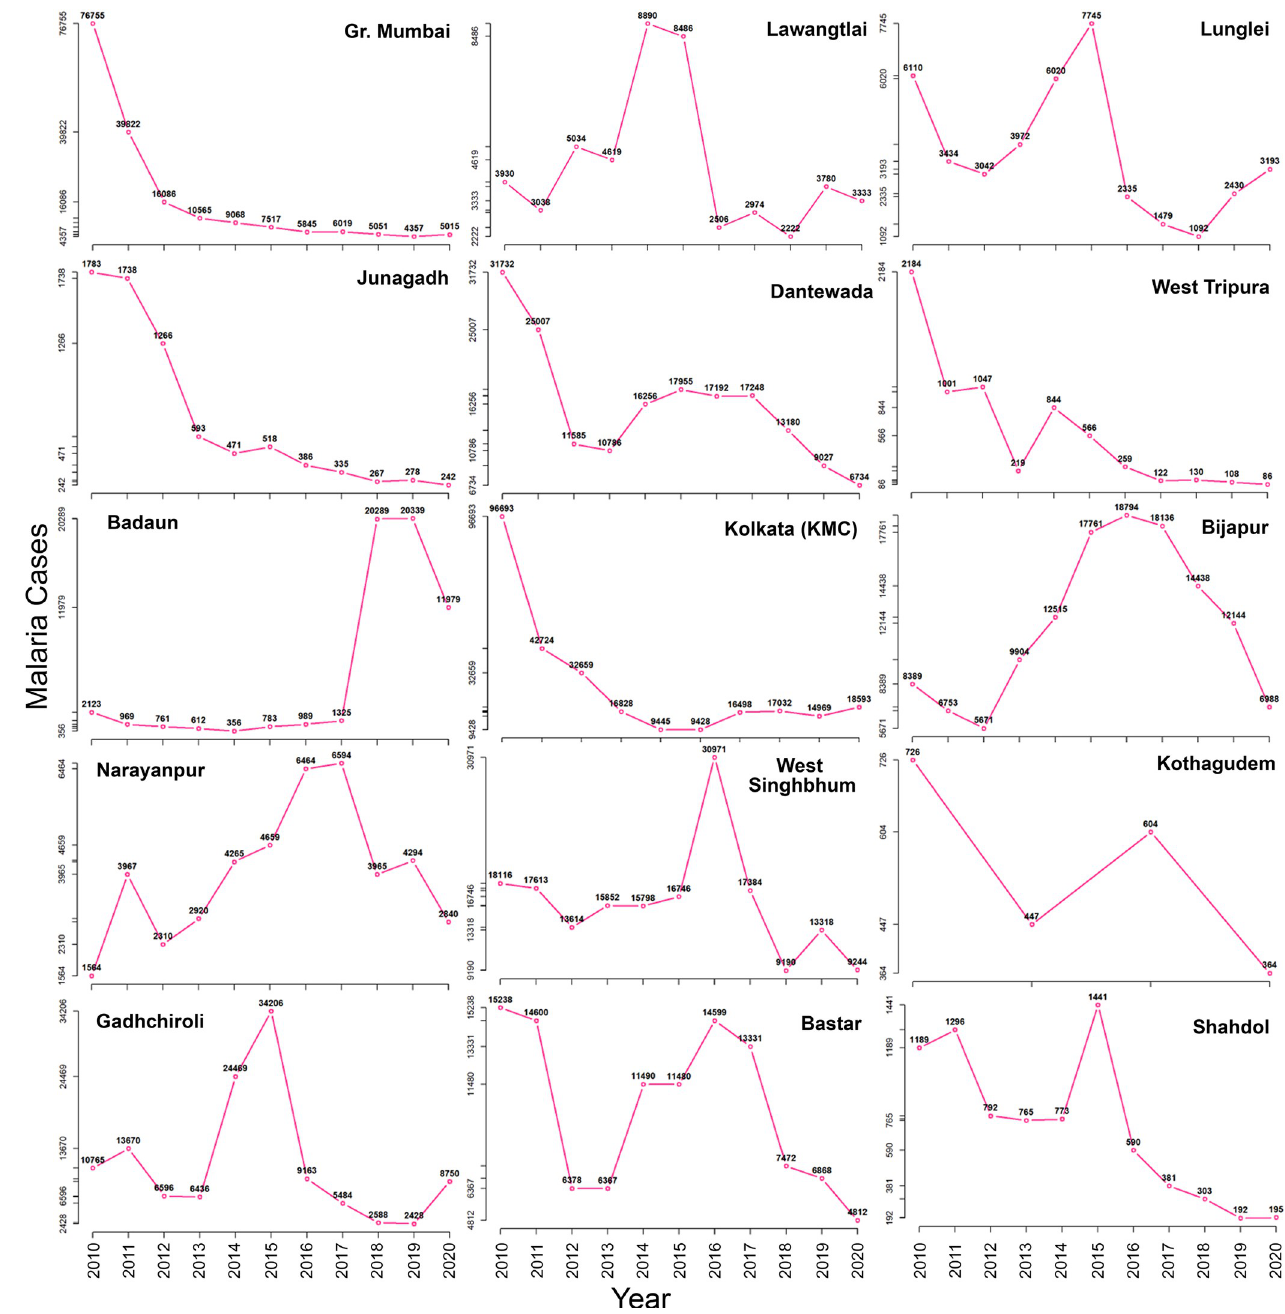
Fig 5. Longitudinal distribution of malaria cases in the last ten years in the cohort of fifteen most vulnerable districts of India that would reach zero case status after 2030 if necessary interventions are not deployed in time. District (State): Greater. Mumbai (MH), Lawangtlai (MZ), Lunglei (MZ), Junagadh (GJ), Dantewada (CT), West Tripura (TR), Badaun (UP), Kolkata (WB), Bijapur (CT), Narayanpur (CT), West Singhbhum (CT), Kathagudem (TG), Gadhchiroli (MH), Bastar (CT) and Shahdol (MP). State Abbreviations: AP-Andhra Pradesh, BR-Bihar, CT-Chhattisgarh, GJ-Gujarat, JH-Jharkhand, KA-Karnataka, MP-Madhya Pradesh, MH-Maharashtra, MZ-Mizoram, OR-Odisha, TN-Tamil Nadu, TG-Telangana, TR-Tripura, UP-Uttar Pradesh, WB-West Bengal.